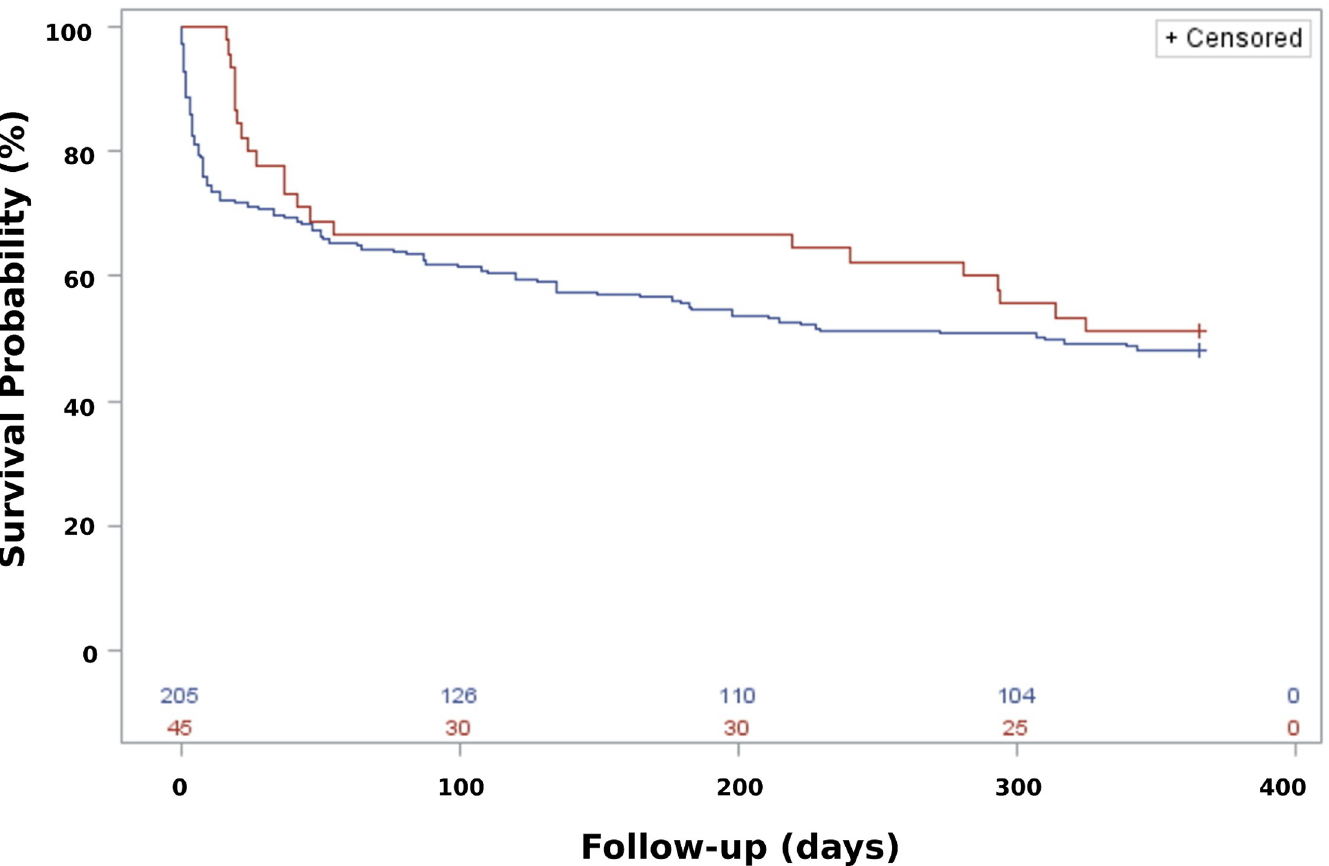
Fig 1. Unadjusted Kaplan-Meier survival estimates by treatment group in patients with pulmonary Pseudomonas aeruginosa . Red line: adequate antibiotic treatment. Blue line: non-adequate antibiotic treatment. Log-rank test: p = 0.41.